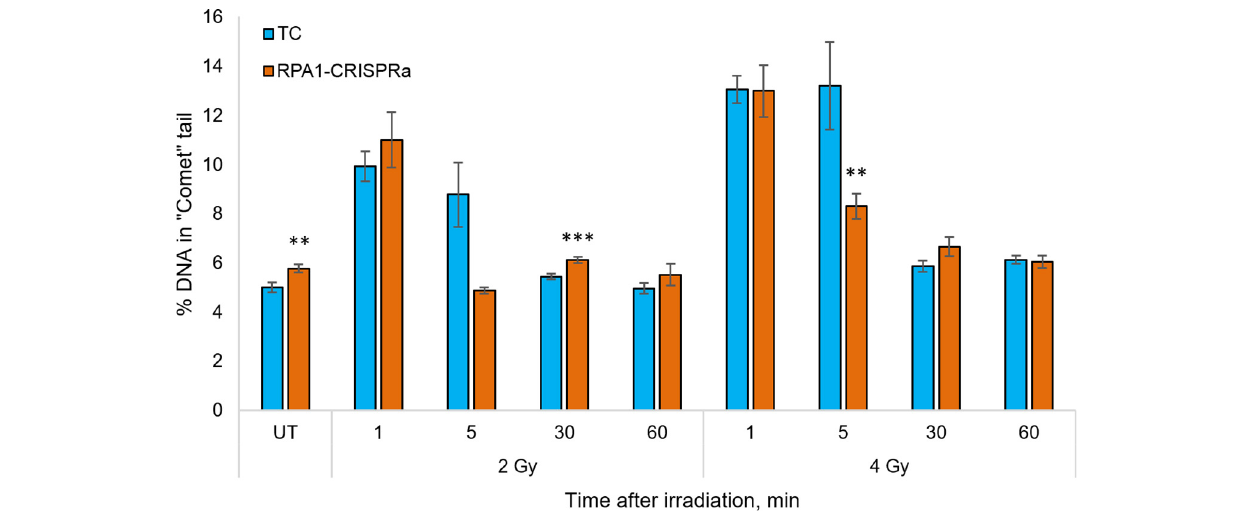
FIGURE 3 | The level of DNA damage in HEK293T cells at 1, 5, 30, and 60 min after irradiation with 2 and 4 Gy. The median value from more than 100 cells per slide were calculated and the mean per nine slides is presented for each group/time point. ** and *** denote statistically significant difference vs. the TC group at p < 0.01 and 0.001, respectively (Student’s t